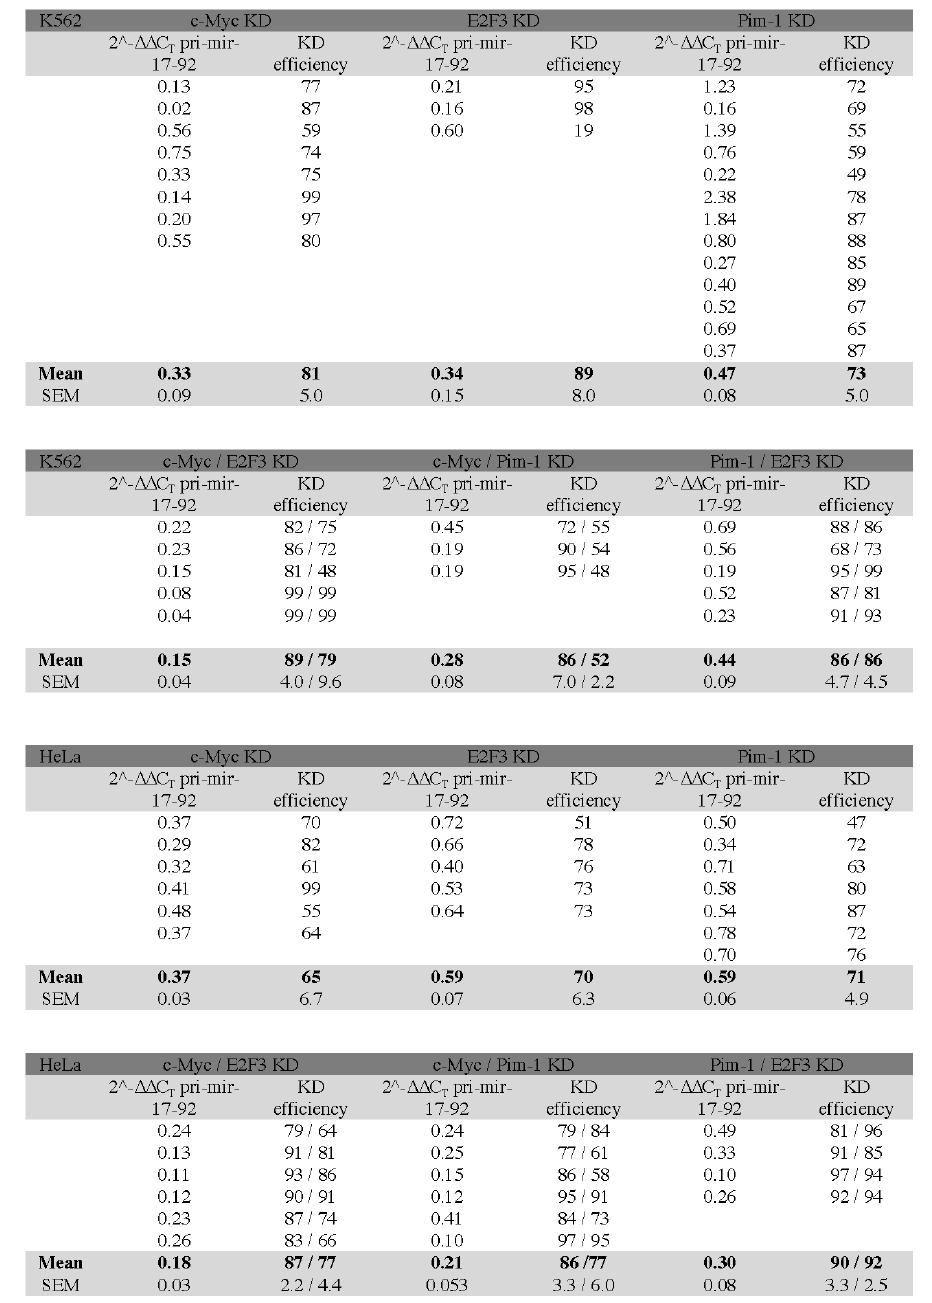
Table S1. Quantification of the pri-miR-17-92 levels and the c-Myc, E2F3 and Pim-1 mRNA levels after siRNA-dependent knockdown by qRT-PCR. Expression levels were calculated from the crossing points by the 2^- ∆∆ C method [38] using β -Actin mRNA or T 5S rRNA as internal controls. To determine the c-Myc, E2F3 and Pim-1 knockdown efficiencies, expression levels were normalized to the levels obtained by transfection of K562- or HeLa cells with an unrelated siRNA directed against the vanilloid receptor